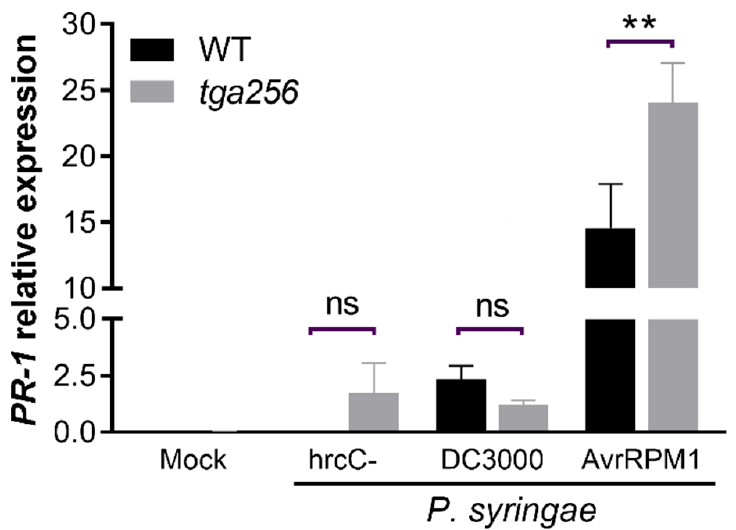
Figure 2. The TGA class II regulation of PR-1 expression is active during the ETI response triggered by Pst DC3000/AvrRPM1, but not during PTI or ETS responses. Four-week-old WT and tga256 mutant plants were syringe-infiltrated with a virulent Pseudomonas syringae DC3000 strain (DC3000), a non-pathogenic hrcC mutant of Pst DC3000 strain (hrcC − ), or the Pst DC3000 avirulent strain carrying the AvrRPM1 gene (AvrRPM1). All strains were infiltrated at OD λ 600 = 0.01 in a 10 mM MgCl 2 solution. In total, 10 mM MgCl 2 was used as a control (mock). Twenty-four hours post inoculation (hpi), the RNA was extracted, and PR-1 expression was evaluated. Bars represent the mean of PR-1 relative expression ± SEM of four biological replicates. Asterisks indicate statistical differences compared to WT plants according to a 2-way ANOVA and Sidak’s post-test (**: p < 0.01), ns = not signif- icant.